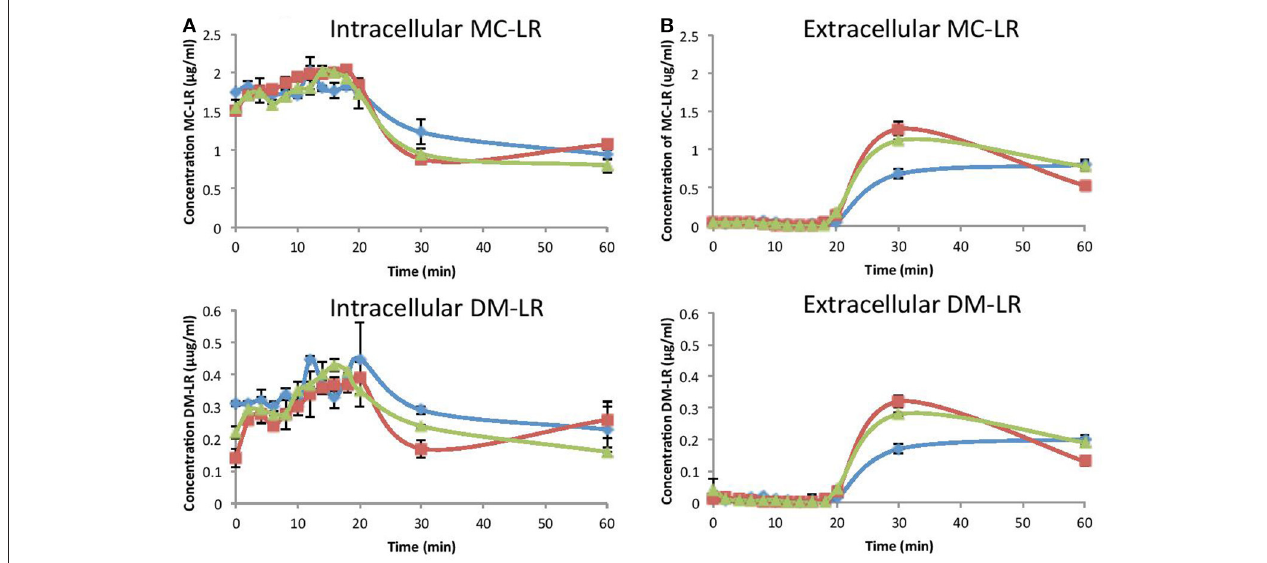
FIGURE 6 | Intracellular and extracellular microcystin concentration at an air flow 1L min − 1 (0.199 ppm O 3 ; Blue), 2L min − 1 (0.265 ppm O 3 ; red) and 3L min − 1 (0.258 ppm O 3 ; green) inside the cells (A) and in the media (B) . Top: MC-LR, Bottom: DM-LR ( n = 3).